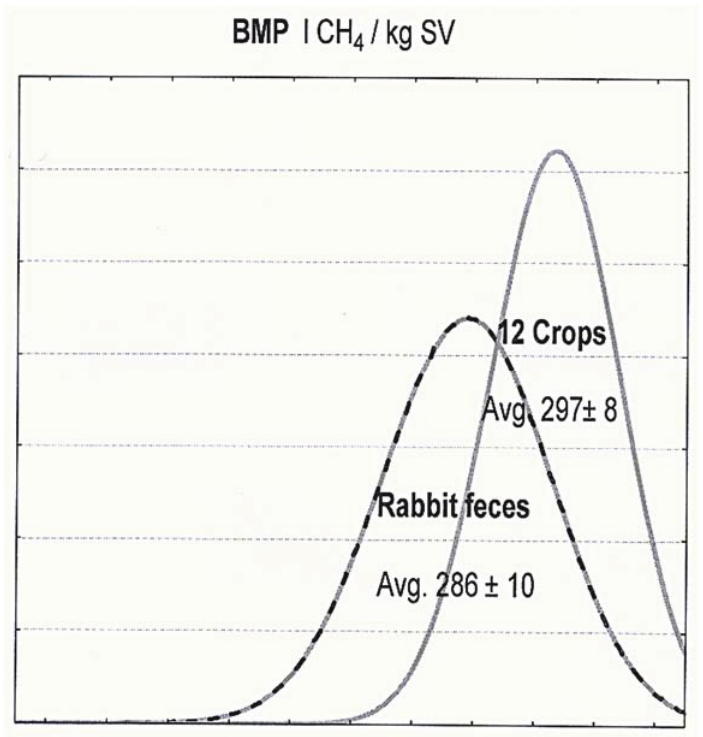
Figure 1. Distribution of the biomethane potential (BMP) of the crops compared to the rabbit feces.